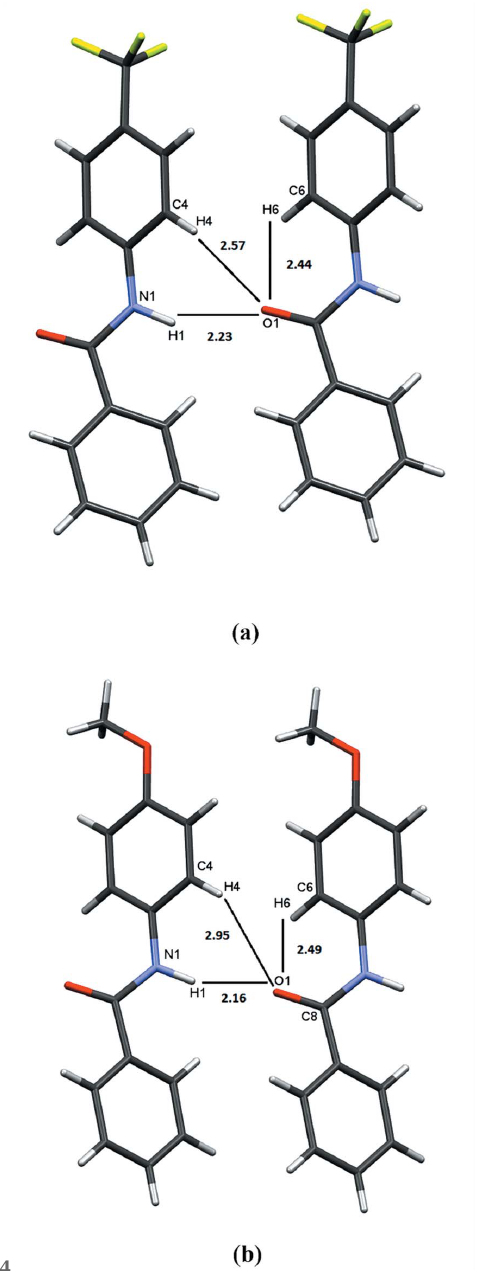
Figure 4 Hydrogen bonding contacts (in A˚ ) in ( a ) TFMP and ( b ) MOP .